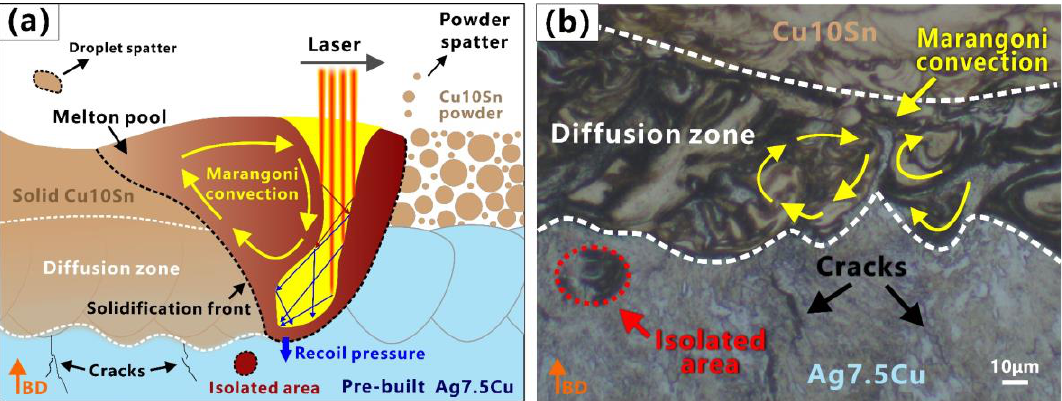
Figure 8. Melting mode of A/C interface in multi-material LPBF: ( a ) schematic illustration of molten pool behavior; ( b ) molten pool morphology at A/C interface. Orange arrows indicate the building direction (BD).